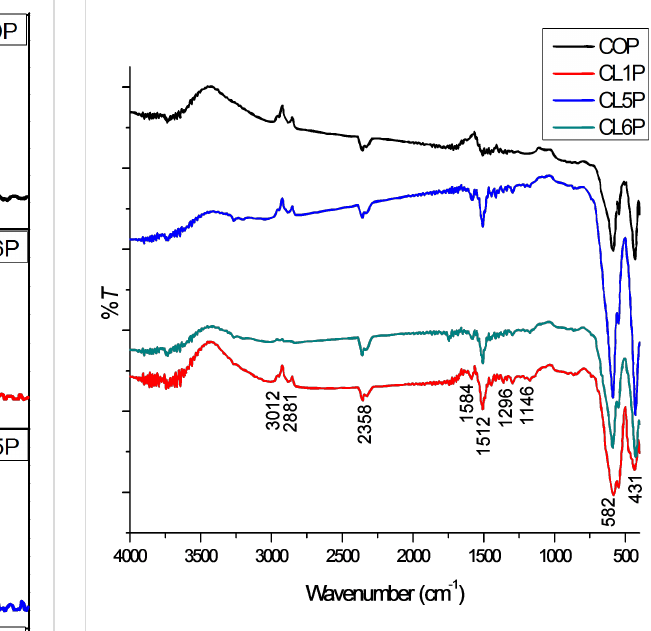
Figure 2: Mid-infrared region spectra for composites COP, CL1P, Cl5P and